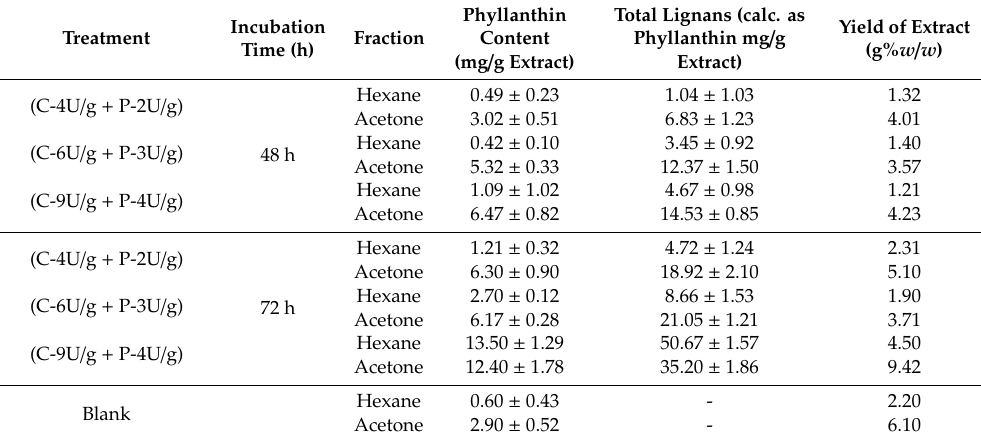
Table 4. The e ff ect of di ff erent concentrations and incubation times of cellulase and protease on phyllanthin and total lignans